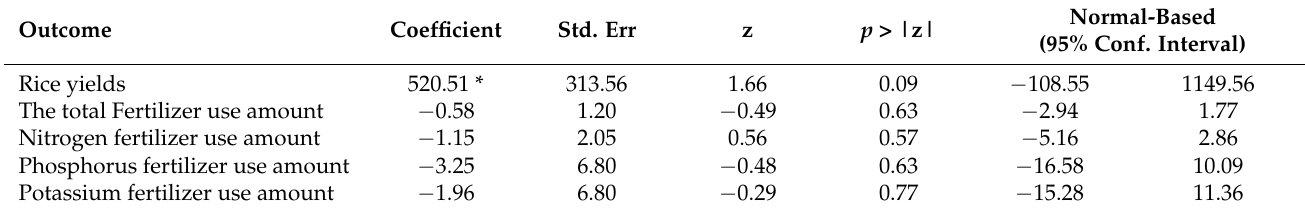
Table 4. Impact of EC on rice yields and nutrient use amount using PSM.